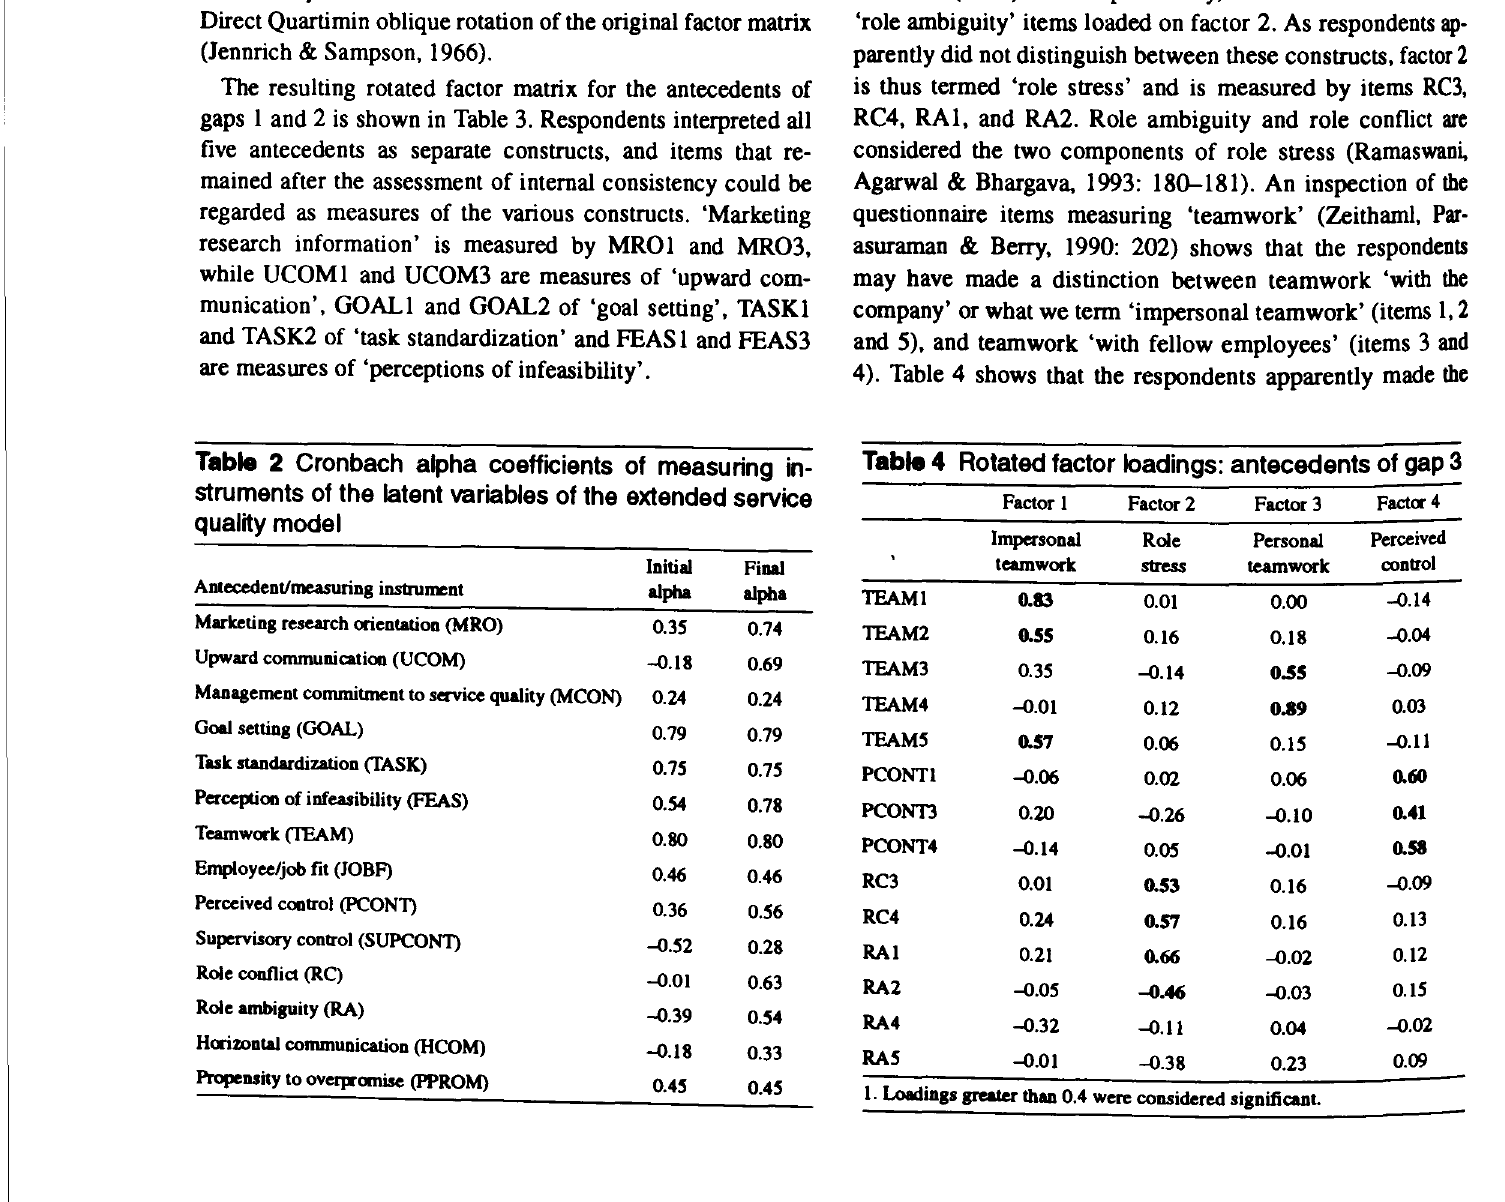
Table 4 Rotated factor loadings: antecedents of gap